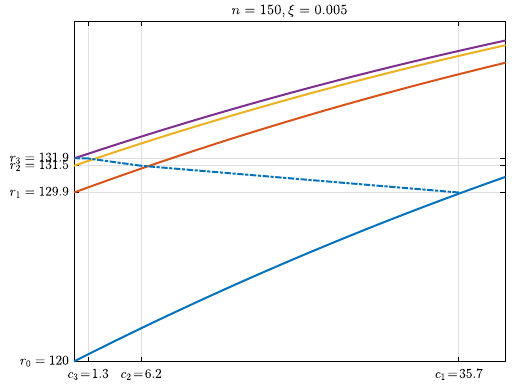
Fig. 6 Demonstration of the asymptotic analysis of r i and c i . The figure presents demonstration of the asymptotic analysis of r i and c i under n = 150 , η = 0.8 and ξ = 0.005